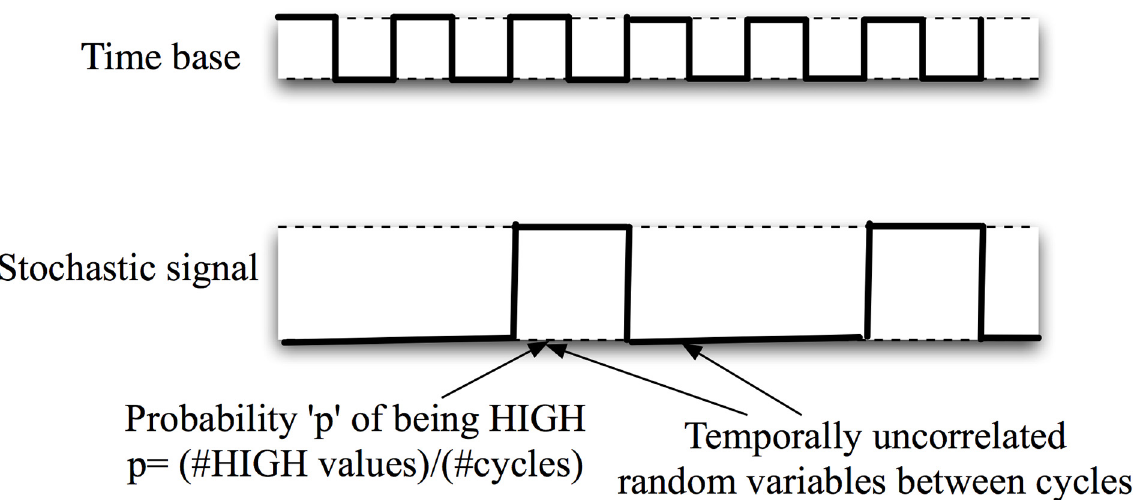
Fig 1. Basic temporal behavior of stochastic signals. There is no correlation between the signal values at different clock cycles. The number associated with the stochastic signal is the activation probability.